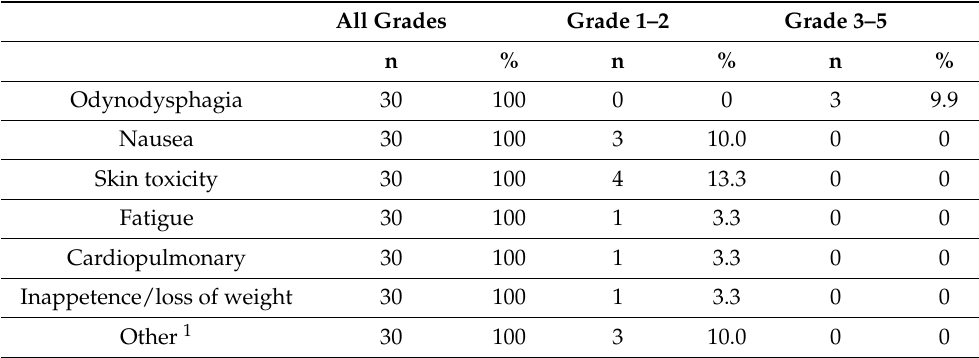
Table 4. Late treatment related toxicities according to CTCAE v5.0, absolute number of patients. All